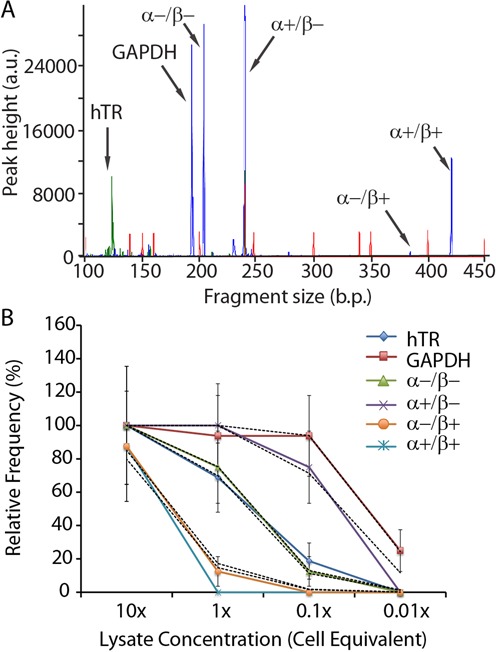
(A) Example of electrophoretic fragment analysis of multiplex RT-PCR from approximately 100 Jurkat cells used to simultaneously detect hTR, GAPDH and 4 potential hTERT splice variants at the α and β splice sites. Primers fluorescently labeled with FITC (blue peaks) and HEX (green peaks) enable accurate product determination and sensitive quantitation. The red peaks are an ROX-labeled size standard. (B) Plot of frequency of positive output reactions versus serial dilutions of Jurkat cell lysate (colored lines) and the least squares Poisson distribution fit (dashed black lines) for each target; close adherence to the Poisson distribution indicates single molecule detection sensitivity and allows estimation of copy number in each sample. The lysate amount equivalent to a single cell contained on average 1.4 α−/β−, 12.5 α+/β−, 0.16 α−/β+ and 0.19 α+/β+ hTERT copies per cell. Average GAPDH and hTR copy numbers could not be determined from this assay since the respective primer pairs were used at 10-fold lower concentrations compared to the hTERT primer pair in order to avoid amplification bias due to their very high native expression levels. N = 18 for each data point. Error bars are Poisson error estimates calculated from the number of positive reactions.